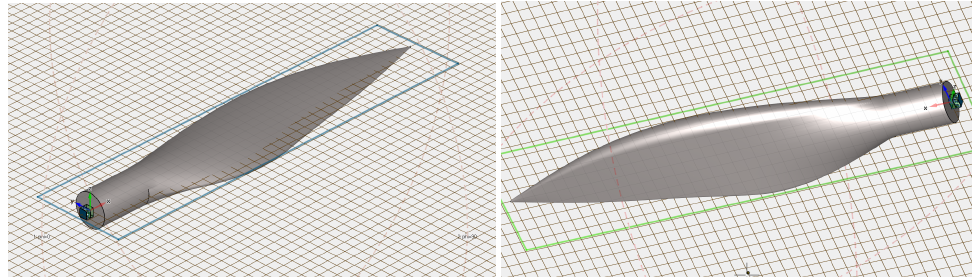
Figure 25. Rotor blade of a turbine with a source.